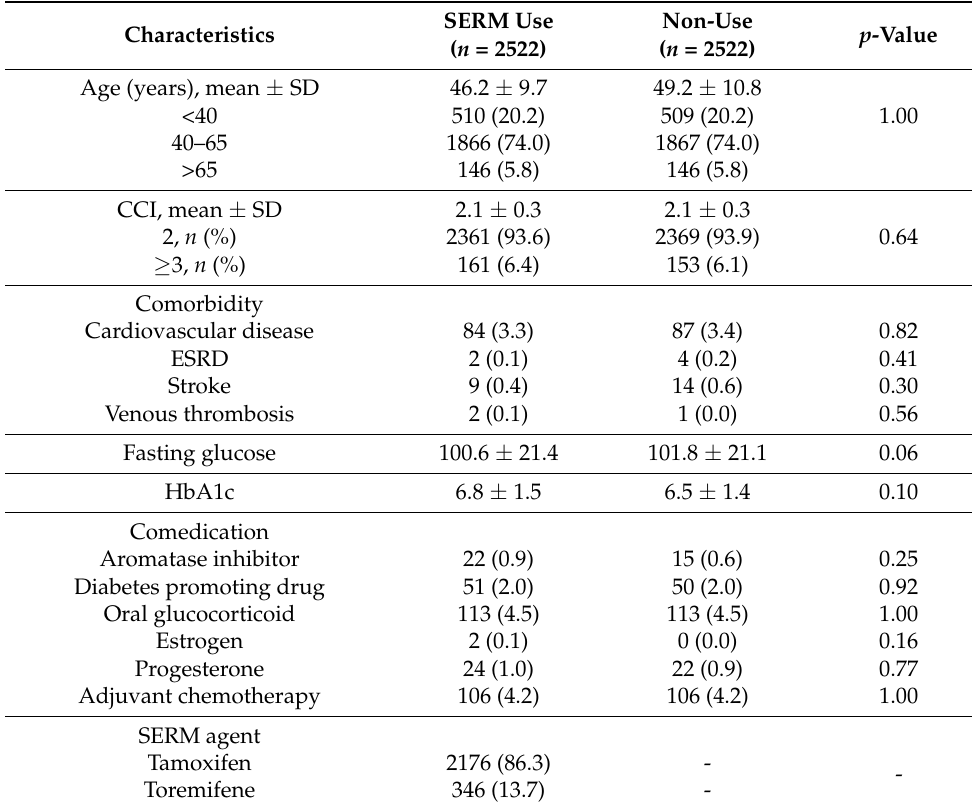
Table 1. Baseline characteristics of female breast cancer patients post PS matching ( n =